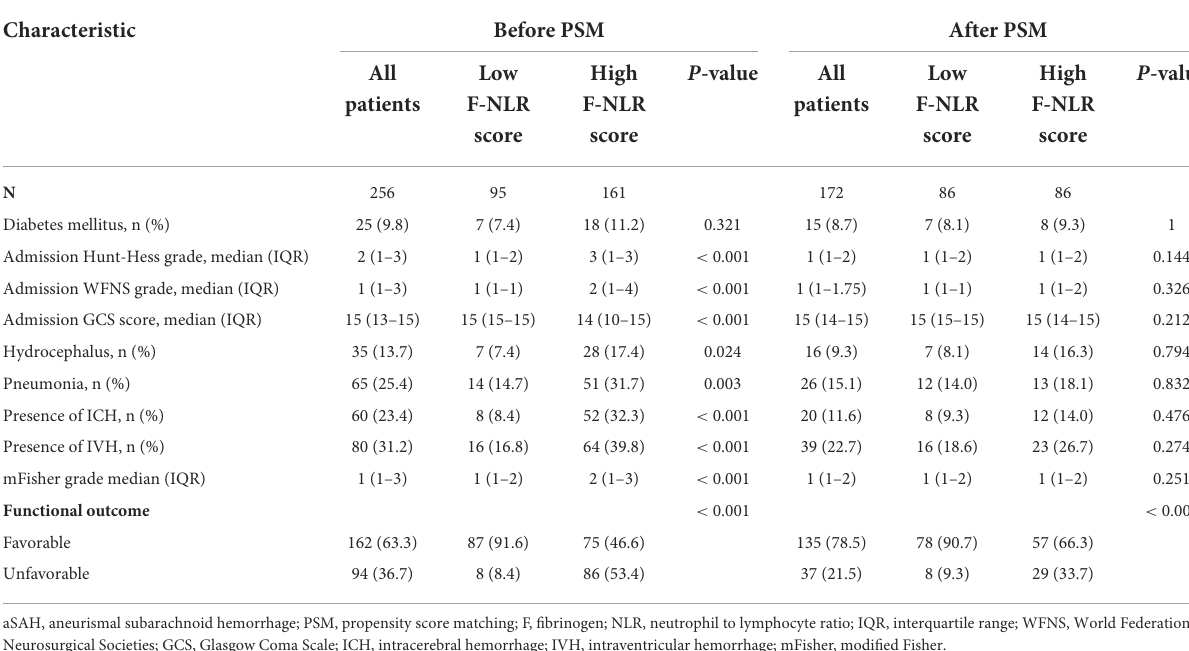
TABLE 4 The clinical characteristics and outcomes in aSAH patients before and after PSM.